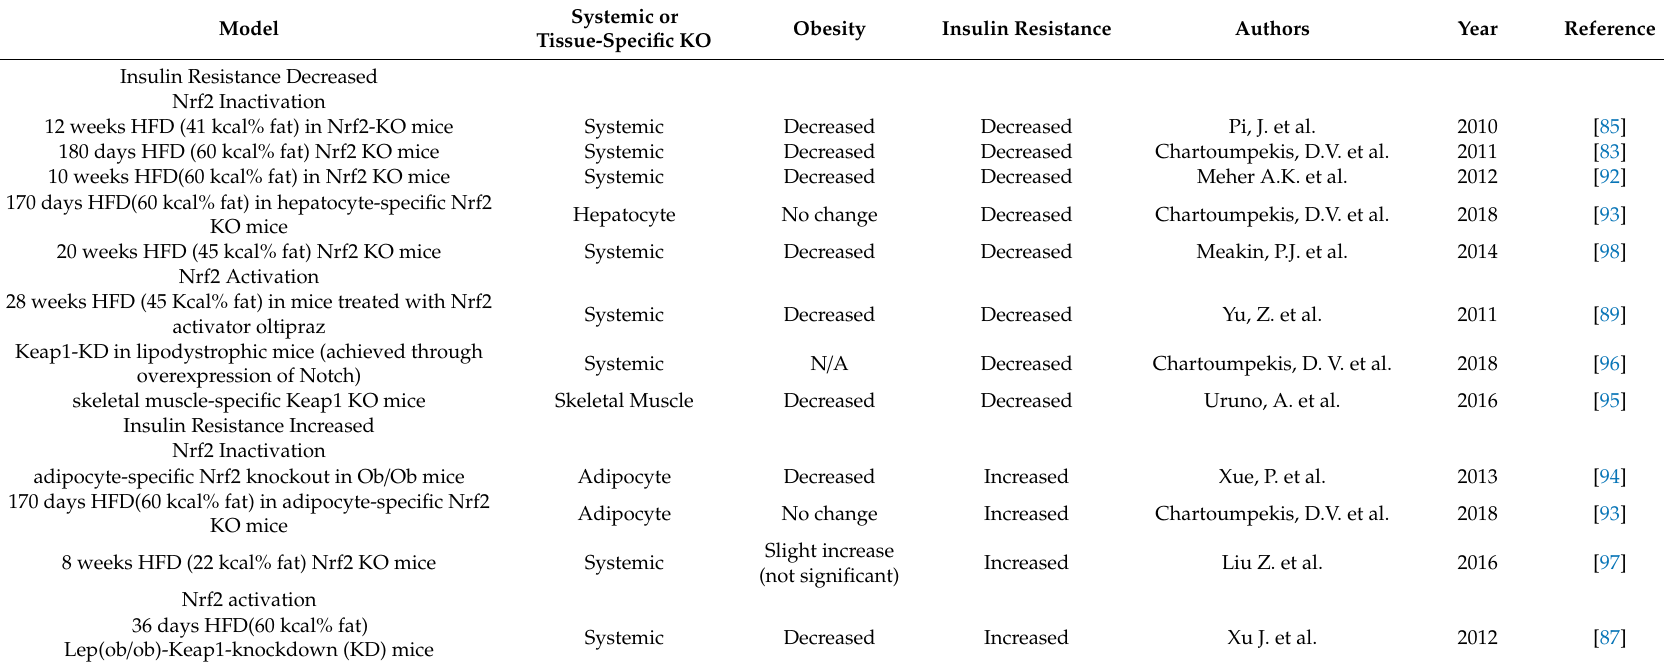
Table 2. The role of Nrf2 pathway in insulin resistance: systemic vs. tissue-specific KO of